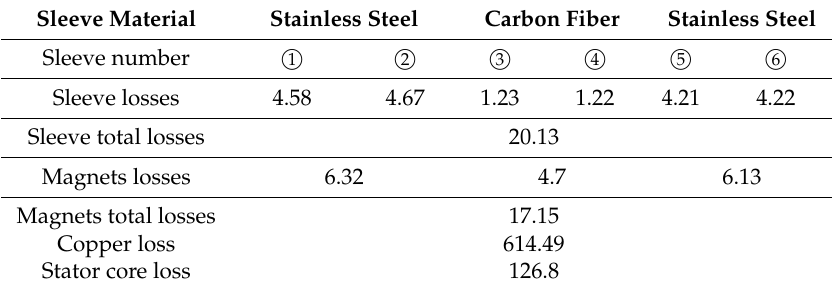
Table 5. Losses in different parts of PMSM